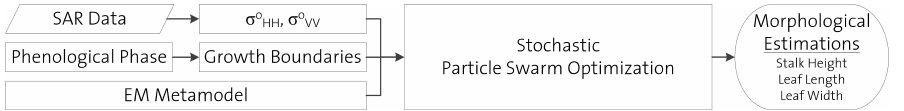
Figure 1. Block-diagram of the proposed stochastic inversion of metamodel-driven electromagnetic scattering (EM) model.